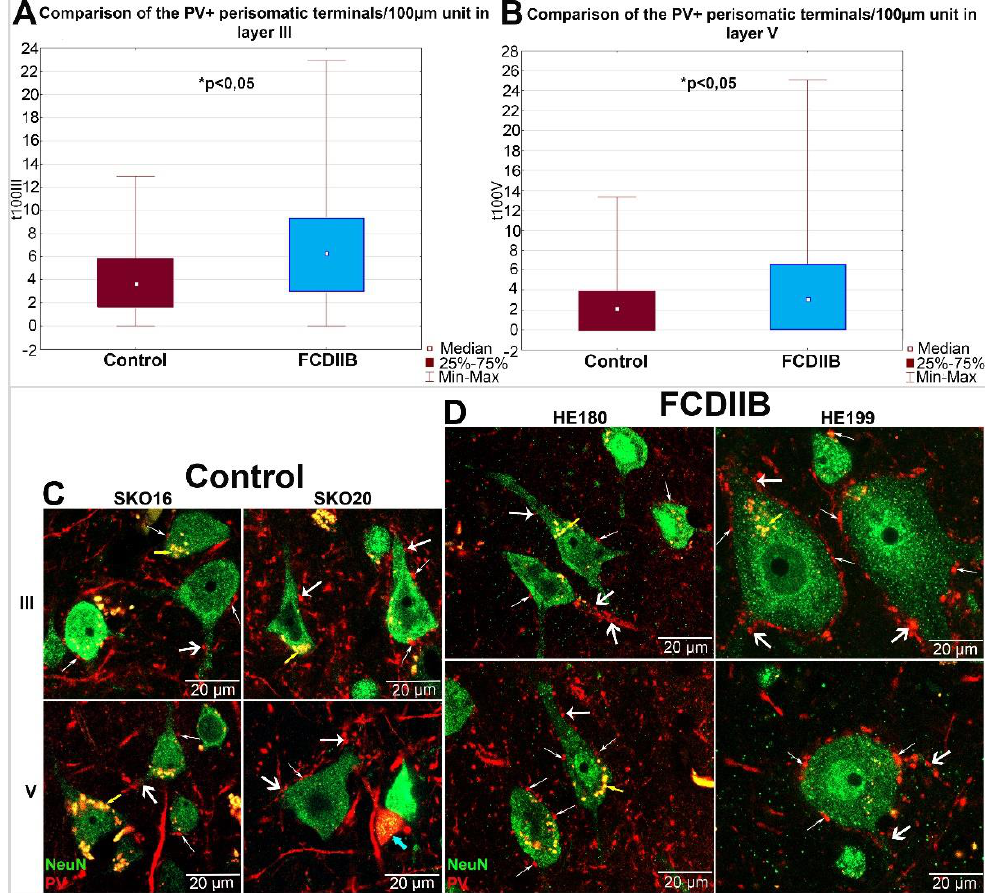
Figure 4. ( A , B ): Boxplots show a statistical comparison of the number of PV-immunopositive perisomatic terminals per 100 µ m length of soma perimeter in control (claret box) and FCDIIB (blue box) subjects in layer III ( A ) and layer V ( B ) by Mann-Whitney U test. Both layers show significant difference in the two measured populations. Layer III: Mann-Whitney U = 35,088, N1 = 336, N2 = 327, p = 6.89 × 10 − 16 ; Layer V: Mann-Whitney U = 41,020, N1 = 332, N2 = 331, p = 7.06 × 10 − 9 ( A , B ). The increase is higher in layer III than in layer V. N1: the number of counted cells in “HE” samples; N2: the number of counted cells in “SKO” samples C, D: NeuN-PV double-immunostained cells in the prefrontal cortex of control ( C ) and FCDIIB ( D ) subjects in layers III and V with confocal fluorescence imaging. NeuN-immunopositive cells are green, PV-immunostained inhibitory cells (blue arrow), fibers and terminals are red. The perisomatic terminals are labeled with small, the terminals of the apical dendrites with narrow white arrows. The thick white arrows show the terminals at basal dendrites. Smaller and larger principal cells are mixed in layers III and V. However, abnormal giant principal cells are present in the HE199 subject in a considerable number. Yellow arrows show the autofluorescent lipofuscin drops. Scales: ( C , D ): 20 µm .